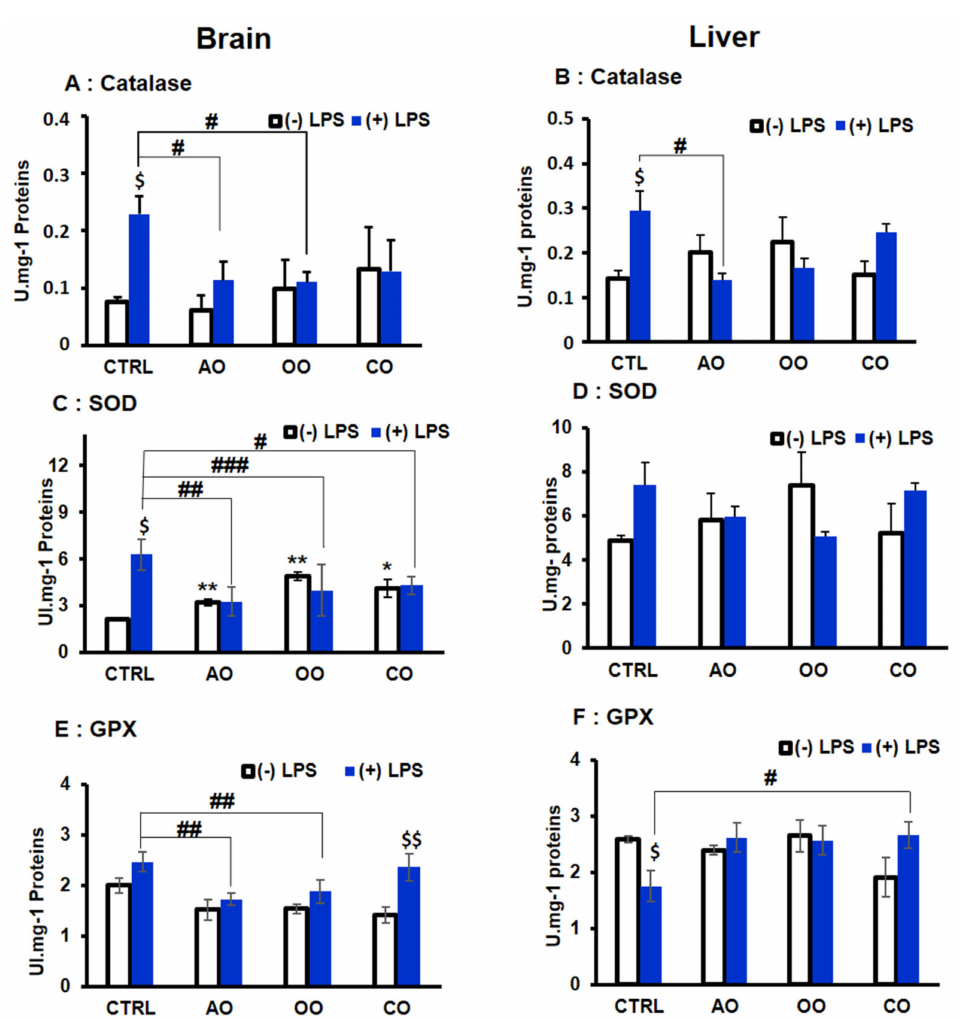
Figure 6. Effect of argan oil, olive oil or colza oil treatment on the antioxidant enzymes activities of CAT ( A , B ), SOD ( C , D ), and GPX ( E , F ) in brain and liver, respectively. C57BL/6 mice received for 28 days a standard diet (control (CTRL)), a diet enriched with 6% ( w / w ) AO, OO, or CO, and intravenous injection of LPS (100 µ g) four hours antemortem. Brain and liver homogenates were prepared as described in Section 4. Results are expressed in (UI.mg − 1 = µ mol of substrate trans- formed/minute/mg of proteins). All values are means ± SD ( n = 3), statistical significance of higher mean signal strength (** p ≤ 0.01. * p ≤ 0.05) compared to control, (### p ≤ 0.001, ## p ≤ 0.01, # p ≤ 0.05), compared to LPS and $$ p ≤ 0.01, $ p ≤ 0.05) compared to treatment with or